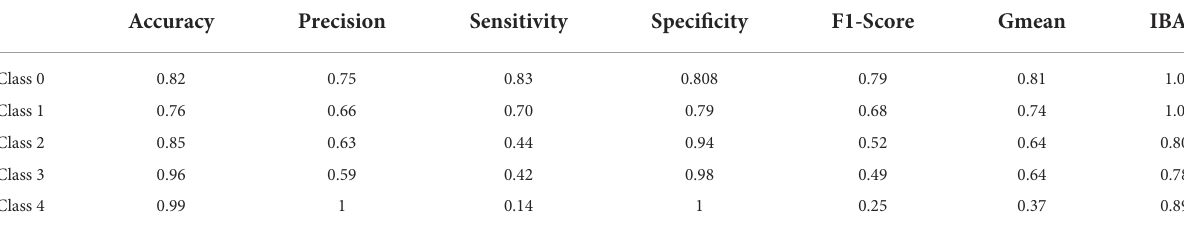
TABLE 6 Performance metrics of XGBoost classifier with imbalance data classification.